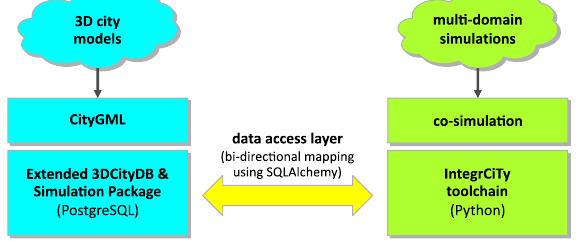
Figure 4. Concept of the IntegrCiTy data access